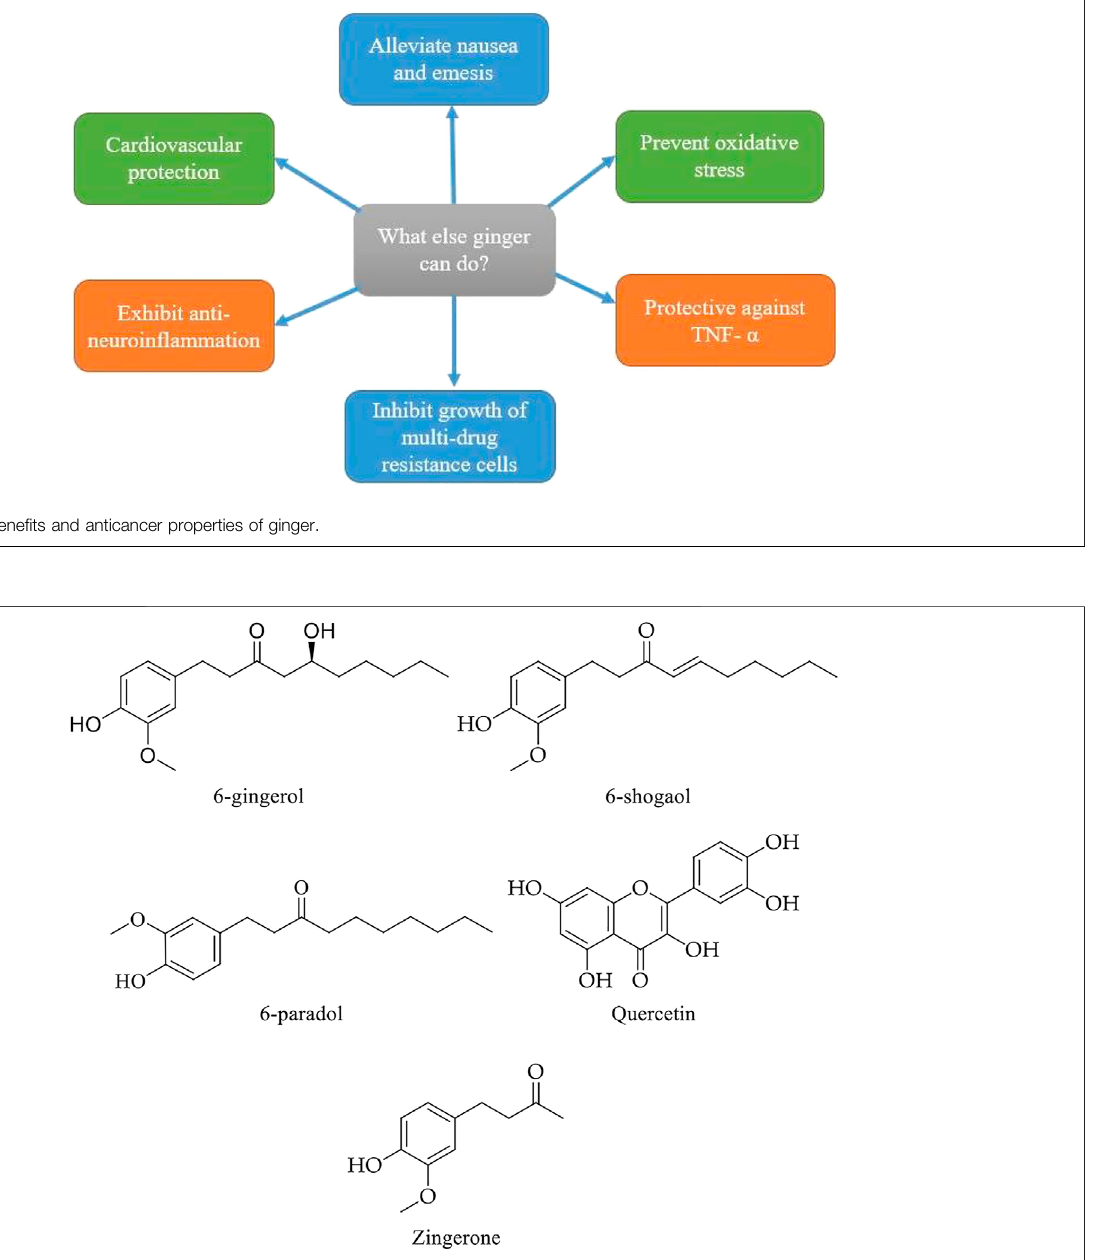
Frontiers in Pharmacology |